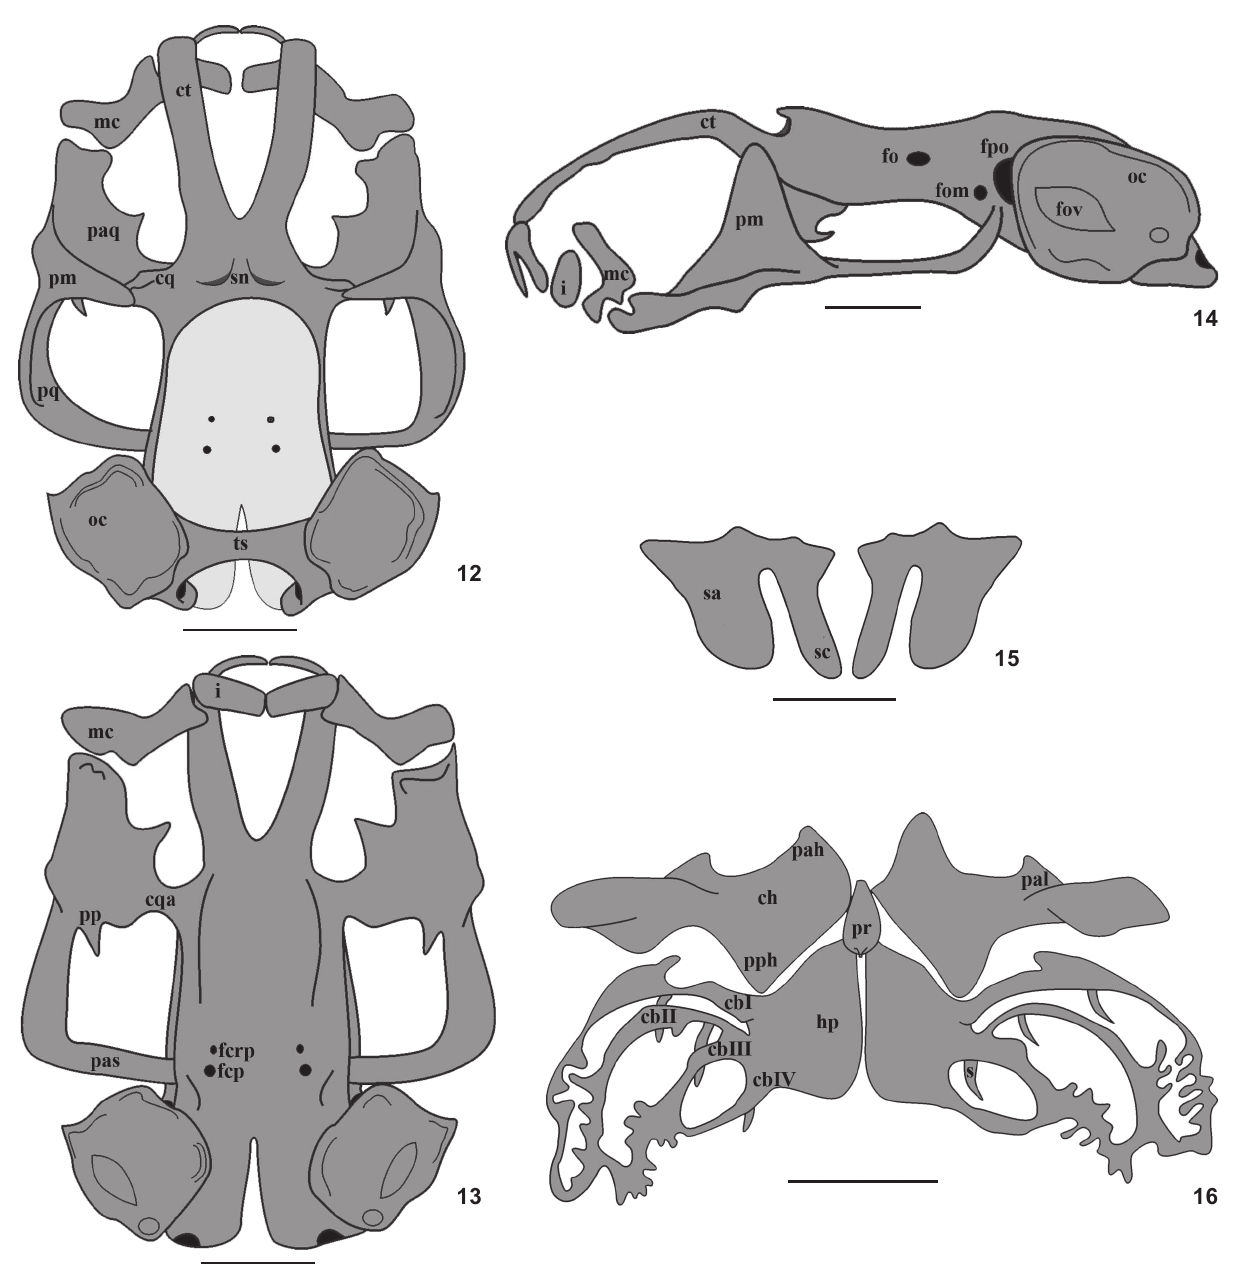
Figures 12-16. Chondrocranium of Proceratophrys izecksohni (UNIRIO 4010), Gosner stage 33: (12) dorsal; (13) ventral; (14) lateral views; (15) suprarostral cartilage; (16) hyobranchial apparatus. (cb I-IV) Ceratobranchials I-IV, (ch) ceratohyal, (cq) commissura quadratoorbitalis, (cqa) commissura quadratocranialis anterior, (ct) cornua trabeculae, (fcp) foramen caroticum primarium, (fcrp) foramen craniopalatinum, (fo) foramen opticum, (fom) foramen oculomotorium, (fov) fenestra ovalis, (fpo) foramen prooticum, (hp) hipobranchial plate, (i) infrarostral caratilage, (mc) Meckel cartilage, (oc) otic capsule, (pah) processus anterior hyalis, (pal) processus anterolateralis hyalis, (paq) pars articularis quadrati, (pas) processus ascendens, (pm) processus muscularis, (pp) processus pseudopterygoideus, (pph) processus posterior hyalis, (pq) palatoquadrate, (pr) pars reuniens, (s) spicules, (sa) suprarostral alae, (sc) suprarostral corpus, (sn) septum nasi, (ts) tectum synoticum. Scale bars = 0.5 ZOOLOGIA 31 (2): 181–194, April, 2014